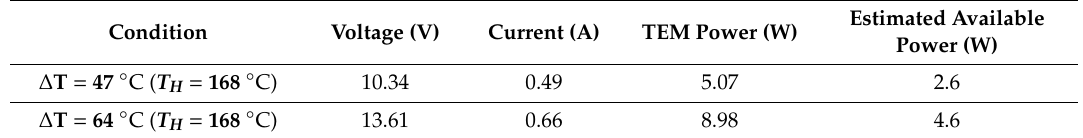
Table 2. Thermoelectric energy module (TEM) outputs .